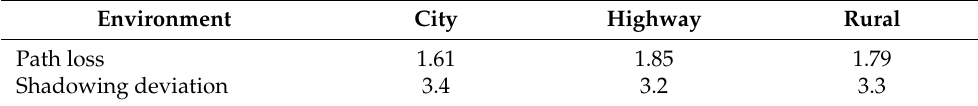
Table 3. Channel parameters [52].